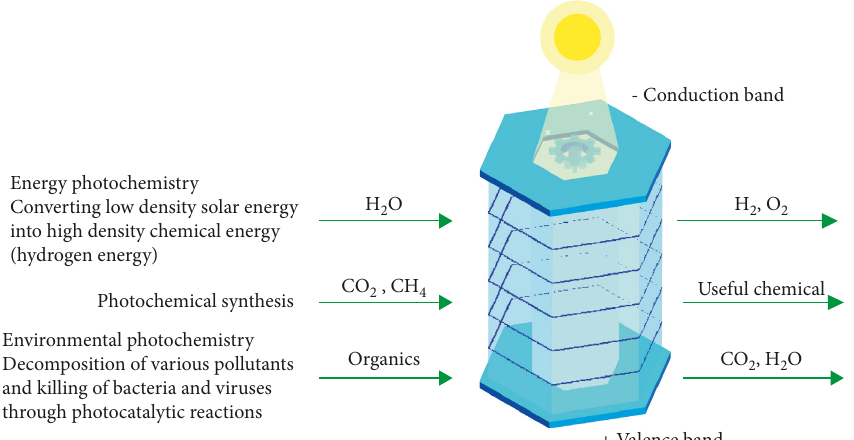
Figure 1: Nano-ZnO and its photocatalytic property.